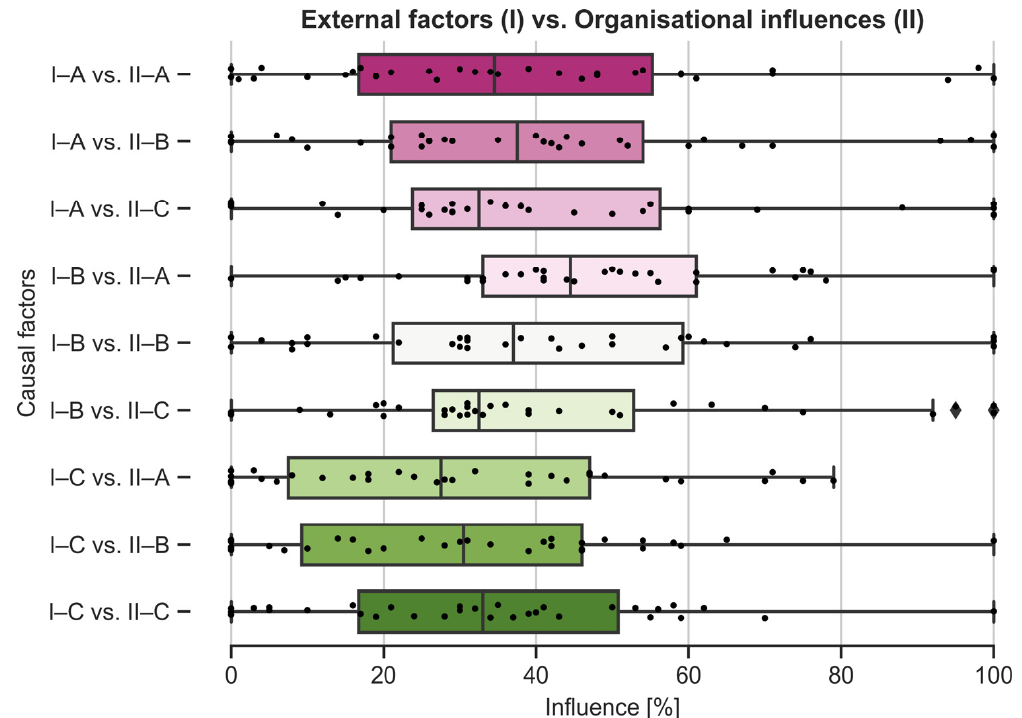
Figure 2. Histograms with kernel density estimation (KDE) of the responses collected on a particu- lar stage.